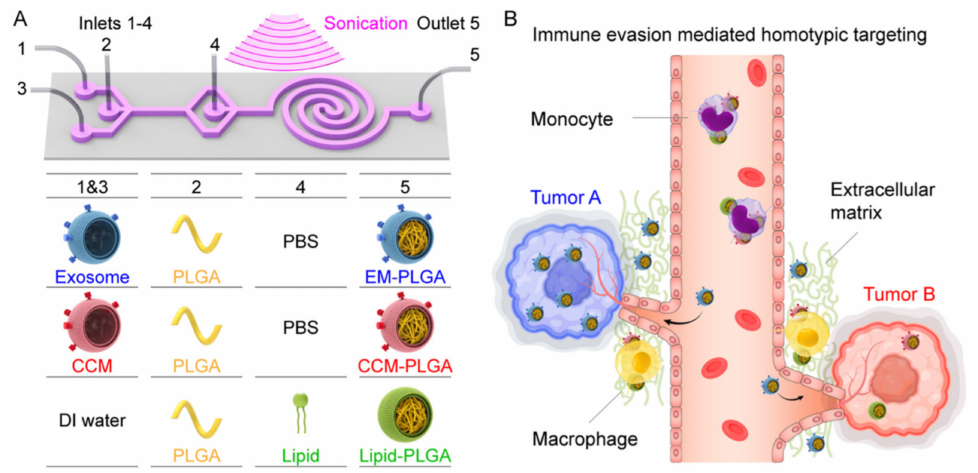
Figure 3. Schematic of the microfluidic sonication method proposed by [41] to assemble biomimetic core-shell nanoparticles. ( A ) The microfluidic chip uses sonication and hydrodynamic mixing methods for the synthesis of exosome membrane (EM)-, cancer cell membrane (CCM)-, and lipid- coated nanoparticles. The precursors are injected into the chip from the inlets (1–4), and the product is collected from the outlet. ( B ) Reduced uptake of the produced biomimetic nanoparticles by the peripheral blood monocytes and extracellular matrix macrophages is shown. Reprinted with permission from C. Liu, et al., 2019 Nano Letters 19(11), 7836–7844 [41]. Copyright 2019 American Chemical Society.